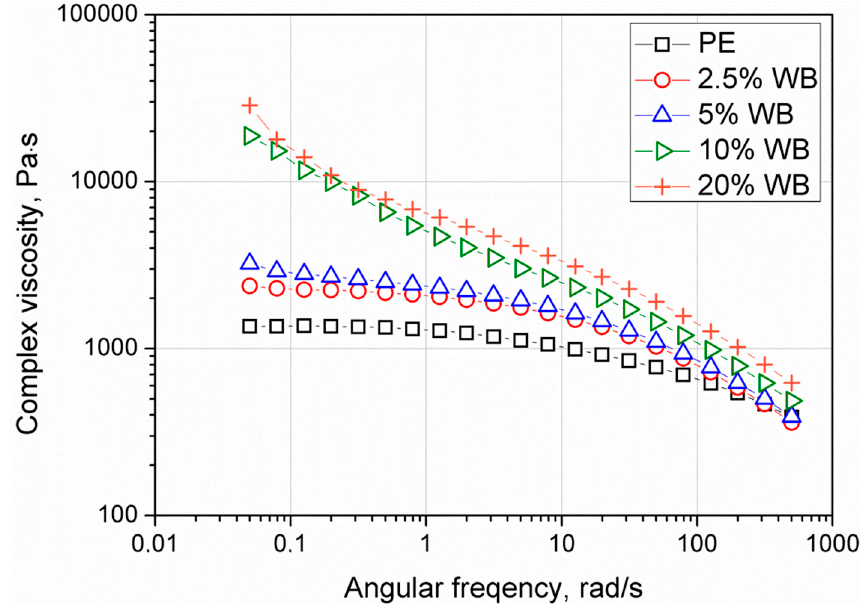
Figure 14. Complex viscosity curved of rotationally molded PE and PE-WB composites.